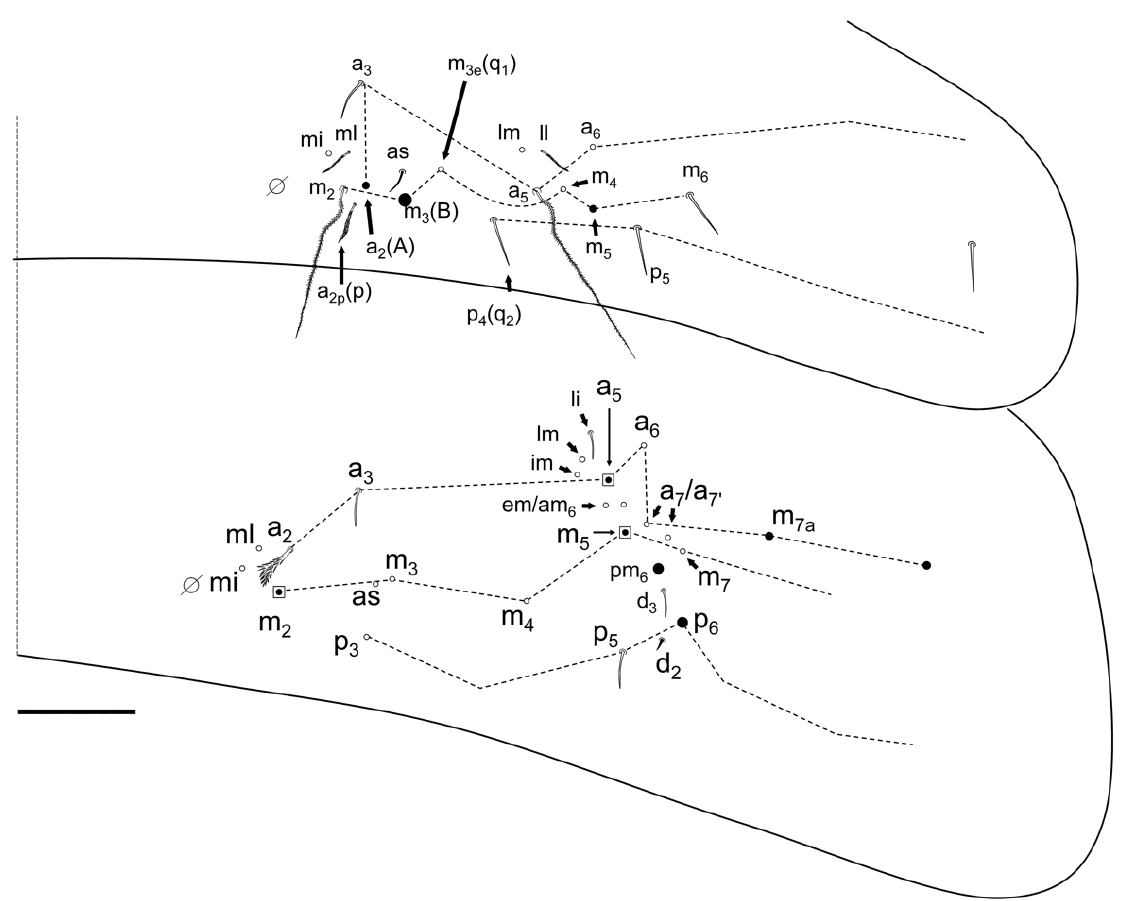
Figure 9. Pseudosinella impariciliata Baquero and Jordana sp. nov.: AbdII–III chaetotaxy (scale bar, 0.05 mm).